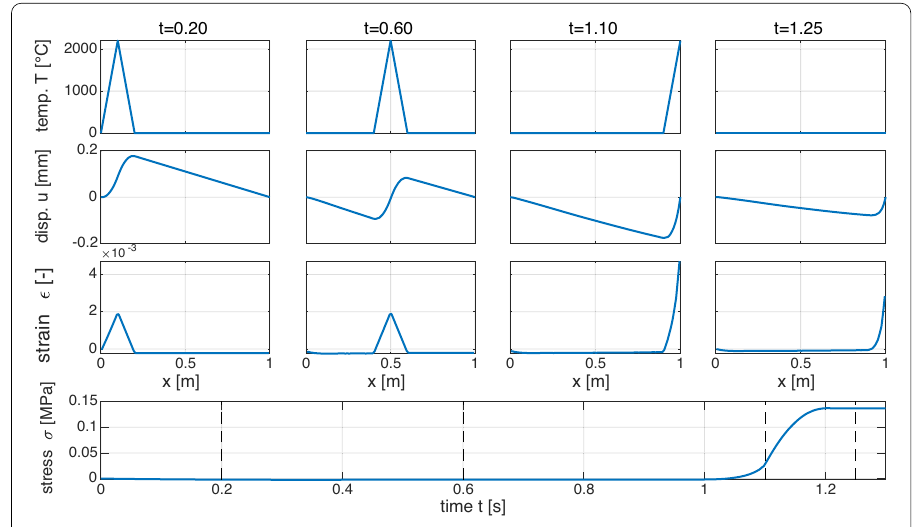
Fig. 7 Temperature, displacement and strain at selected time steps (first three rows) and stress evolution over time for the inhomogeneous temperature load example. Dashed black lines in the time-stress diagram indicate the selected time steps for the upper diagrams